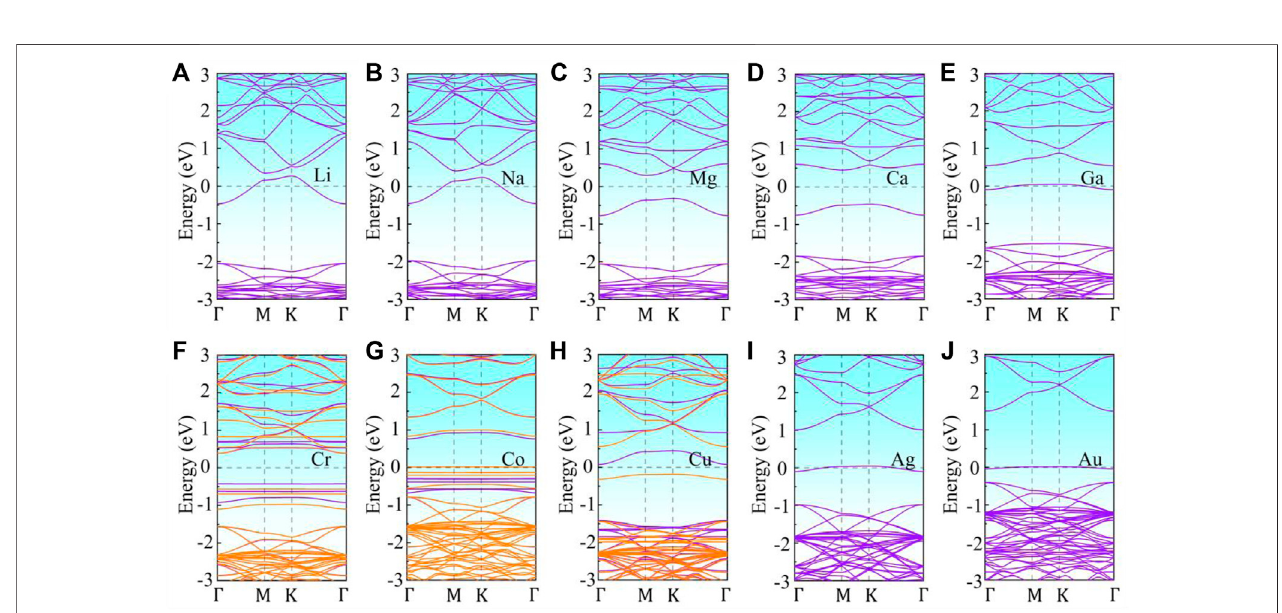
FIGURE 4 | The band structures of M or TM adsorbed g-ZnO systems: (A) Li, (B) Na, (C) Mg, (D) Ca, (E) Ga, (F) Cr, (G) Co, (H) Cu, (I) Ag, (J) Au. Purple line indicates spin up, and orange line denotes spin down. The Fermi level is shifted to zero.